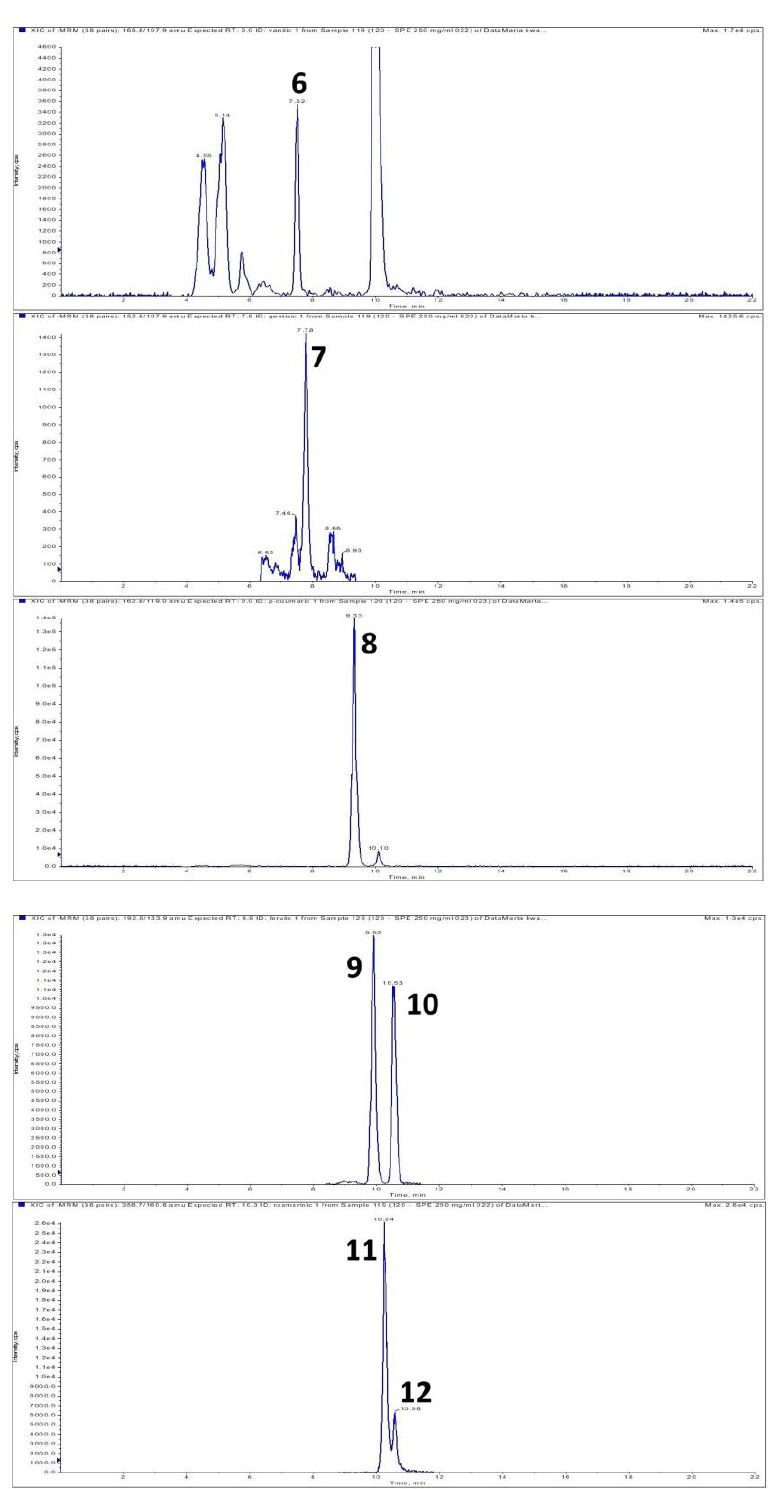
Figure 1. Extracted LC-MS-MRM chromatogram of phenolic acids found in snacks enriched with dragonhead seeds; MRM transitions are given in brackets: 1—protocatechuic ( m / z 152.9–107.8); 2— trans -caffeic ( m / z 178.7–134.9); 3— cis -caffeic ( m / z 178.7–134.9); 4—4-hydroxy-benzoic ( m / z 136.9— 93); 5—salicylic ( m / z 136.9—93); 6—vanillic acid ( m / z 166.8–107.9); 7—gentisic ( m / z 152.8–107.9); 8— p -coumaric ( m / z 162.8–119); 9—ferulic ( m / z 192.8–133.9); 10—isoferulic acid ( m / z 192.8–133.9); 11— trans -rosmarinic acid ( m / z 358.7–160.8); 12— cis -rosmarinic acid ( m / z